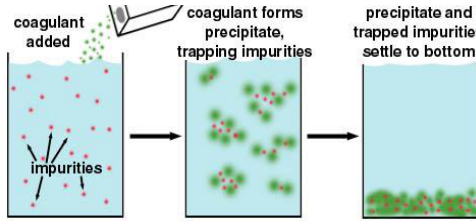
Figure 2. Coagulation/flocculation process [5].